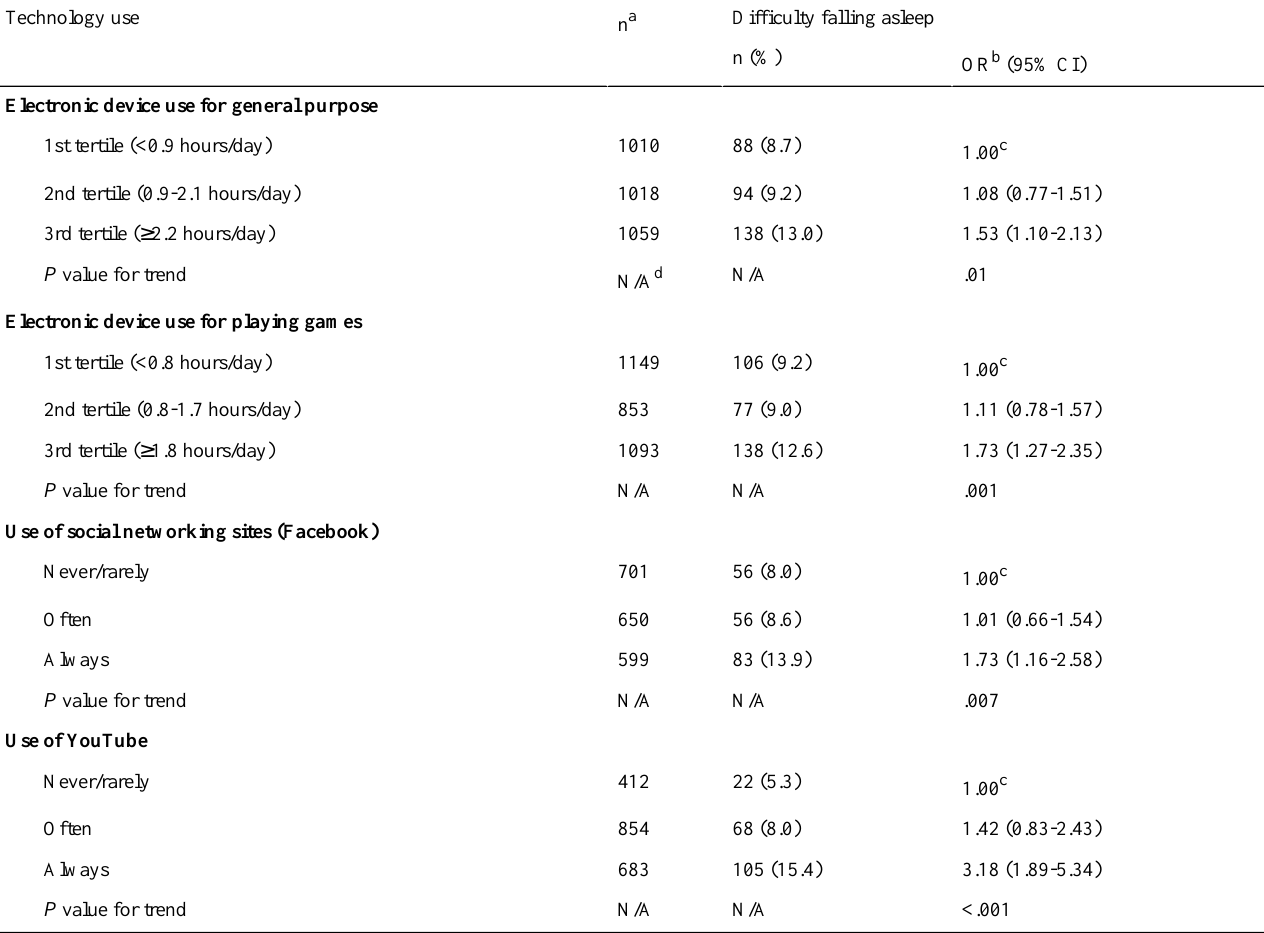
Table 3. Distribution of 3172 adolescents with severe sleep difficulties overall and by technology and social media use and corresponding odds ratios and 95% CIs (Lombardy,